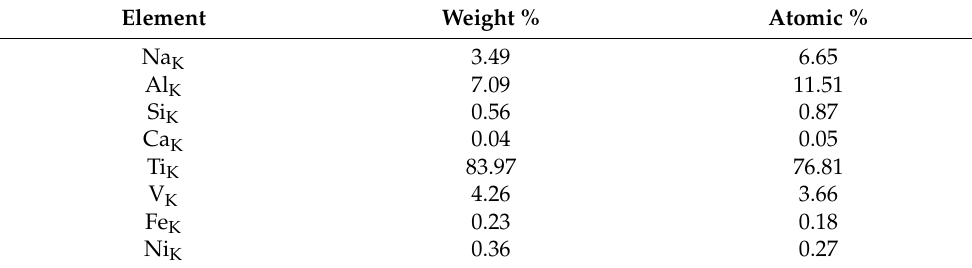
Figure 3. SEM images of the implant surface: ( a ) General view; ( b ) enlarged fragment; ( c ) general ED spectrum from the dark area; ( d ) enlarged section of ED spectrum from the dark area; ( e ) general ED spectrum from the light area. Table 1. Quantitative composition of one of the dark areas. Table 1. Quantitative composition of one of the dark areas. Element Element